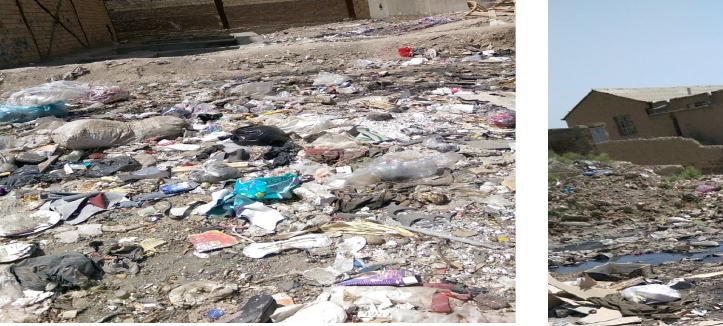
Figure 6. Waste disposed on vacant grounds Figure 7. Industrial